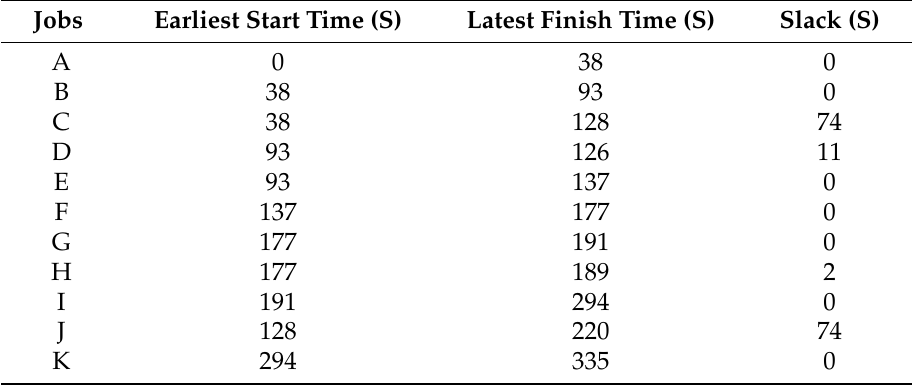
Table 4. Attributes of second iteration.